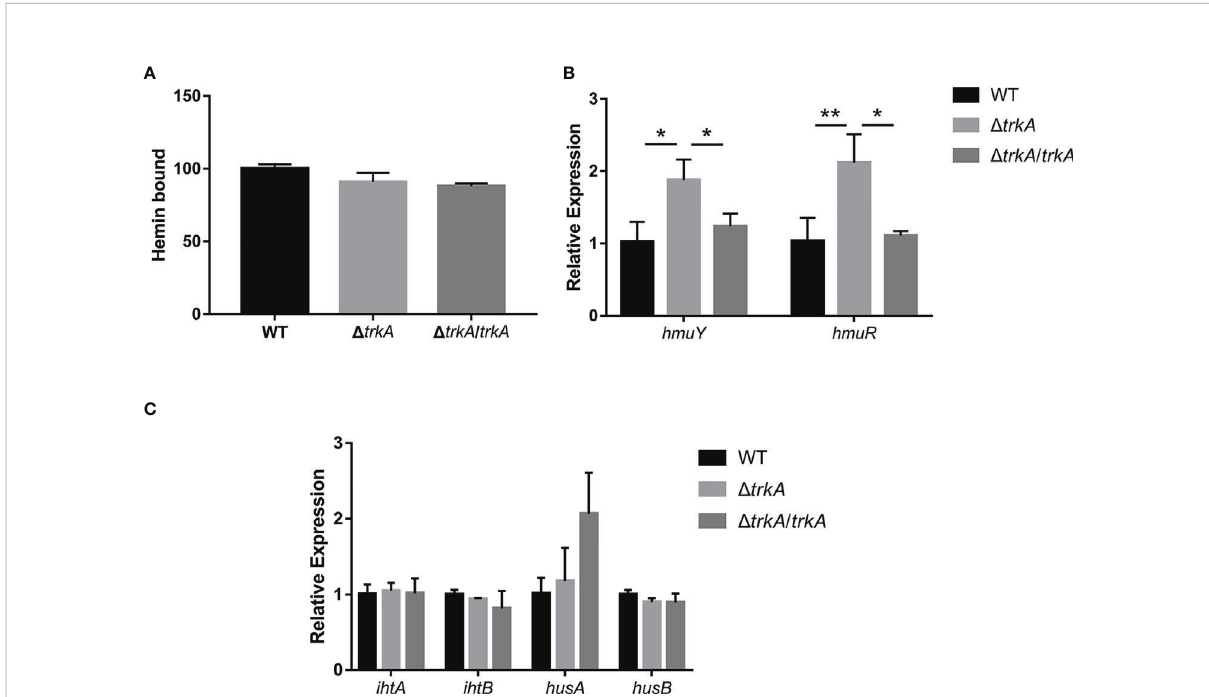
FIGURE 4 Heme-bound capacity of Porphyromonas gingivalis is not altered except for the corresponding transcripts. (A) Heme-bound assay. qRT-PCR of (B) hmuYR and (C) ihtAB and husAB mRNA expression of P. gingivalis WT, D trkA , and D trkA / trkA strains. Data are presented as means ± SD, normalized to 16S rRNA and compared to WT (2 − DD CT ). N = 3, * p < 0.05, ** p <